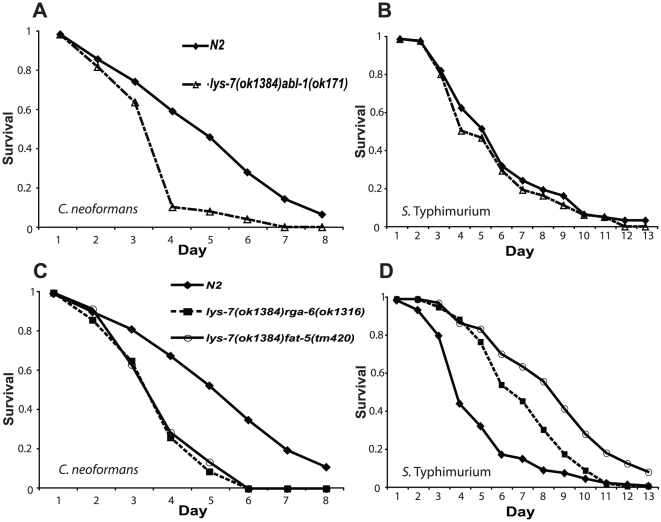

lys-7;abl-1 double mutants suppress the tolerance resistance phenotype.
lys-7(ok1384)abl-1(ok171) double mutants remain hypersensitive to C. neoformans (A), similar to their corresponding single mutants; p<0.0001, [abl-1(ok171)lys-7(ok1384) n = 133; N2 n = 150], but the resistance exhibited by the single mutants to S. Typhimurium infection (B) has been completely suppressed; p>0.2, [abl-1(ok171)lys-7(ok1384) n = 110; N2 n = 94]. Double mutants between lys-7 and fat-5 or lys-7 and rga-6 were hypersensitive to C. neoformans infection (C), p<0.0001 in both cases, [N2 n = 207; lys-7(ok1384)fat-5(tm420) n = 100; lys-7(ok1384)rga-6(ok1316) n = 100]. Similarly, the resistance to S. Typhimurium exhibited by the lys-7 knockout strain was either unaltered (fat-5) or only slightly reduced (rga-6) by these secondary mutations (D), [N2 n = 170; lys-7(ok1384)fat-5(tm420) n = 100; lys-7(ok1384)rga-6(ok1316) n = 100].